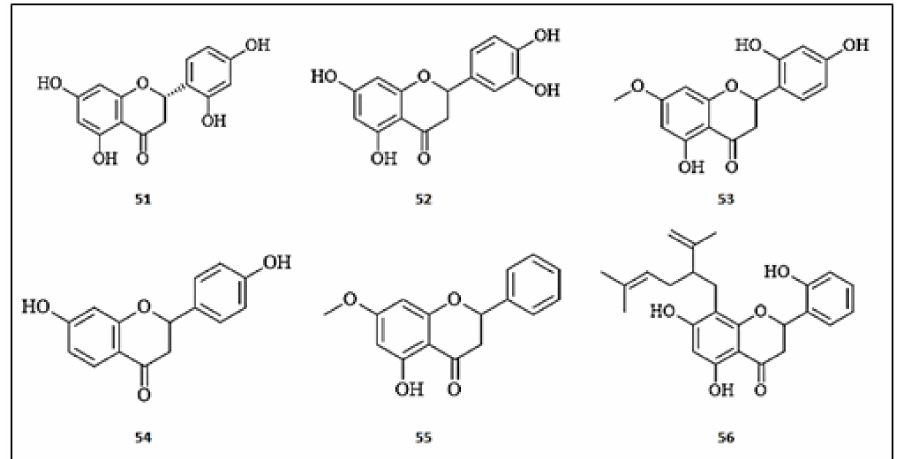
Figure 6. The chemical structures of flavanones with anti-tyrosinase activity. ( 51 ) Steppogenin; ( 52 ) Eriodictyol; ( 53 ) Artocarpanone; ( 54 ) Liquiritigenin; ( 55 ) Pinostrobin; ( 56 ) Kushenol